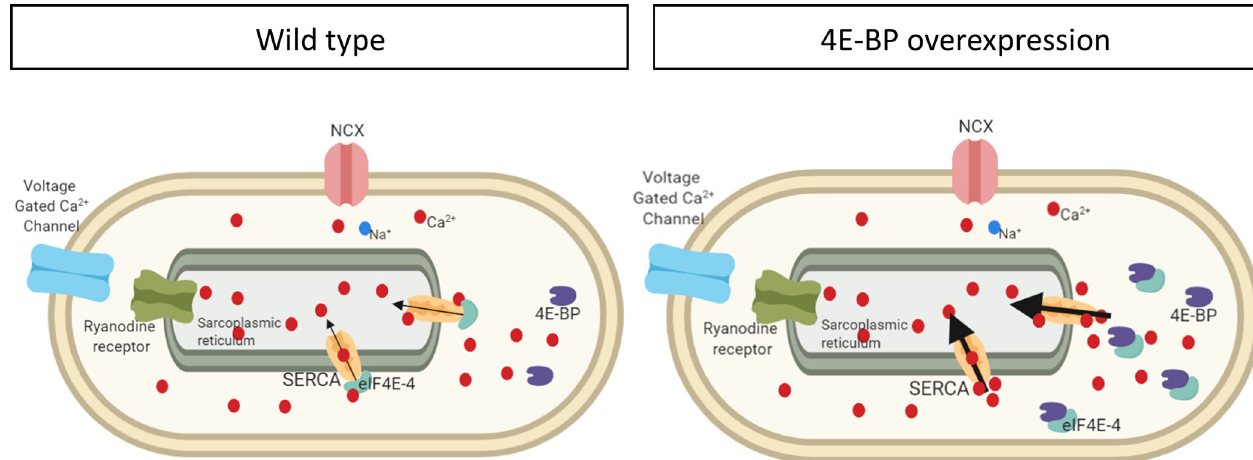
Fig 6. Representative diagram of a wildtype cardiomyocyte and one that overexpresses 4E-BP. This model proposes that overexpressed 4E-BP competes with SERCA for eIF4E-4, thereby reducing eIF4E-4 binding to SERCA and causing increased SERCA activity and improved cardiac performance. Ca 2+ handling-proteins are indicated: Voltage gated Ca 2+ channel, eukaryotic translation initiation factor, variant 4 (eIF4E-4), Ca 2+- ATPase (SERCA), ryanodine receptor, Na + /Ca 2+ exchanger (NCX), calcium ion (Ca 2+ ), sodium ion (Na + ).